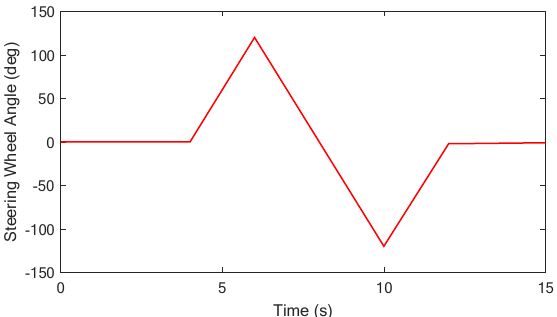
Figure 16. Steering wheel angle at the sinusoidal line shift condition.